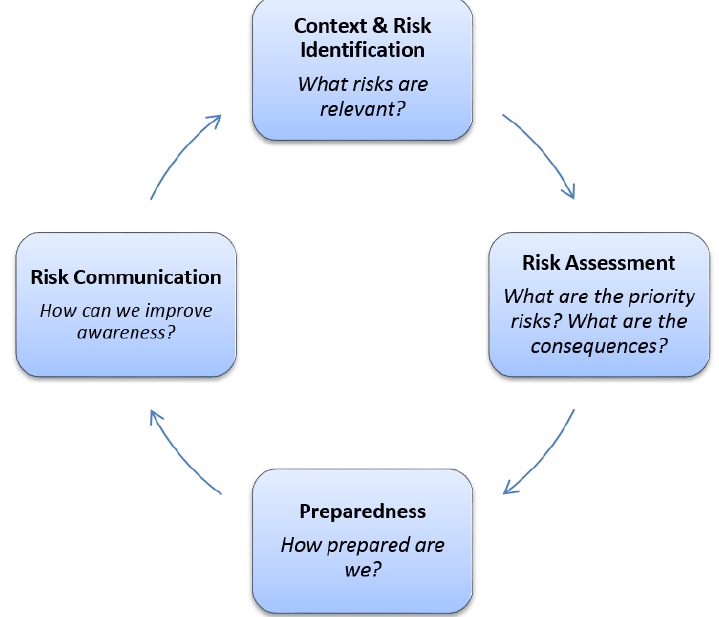
Figure 1. Risk and Preparedness Assessment (RPA) cycle as used in Government contingency